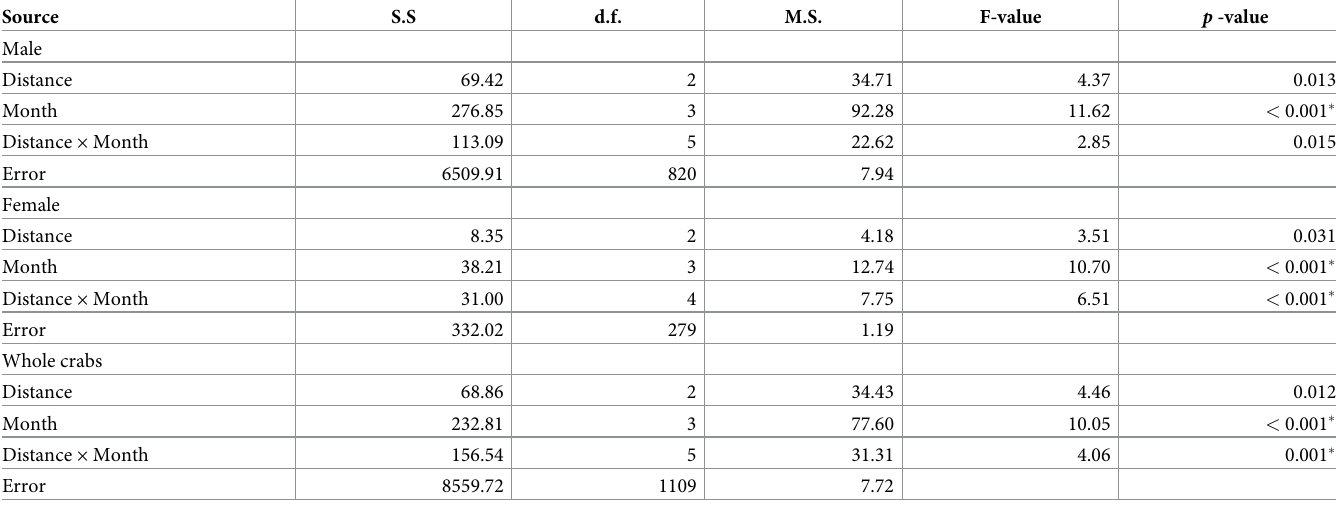
Table 3. Statistical results of two-way ANOVA of the wet weight of two genders and whole crabs of Xenograpsus testudinatus with a different sampling distances and different sampling months. Source